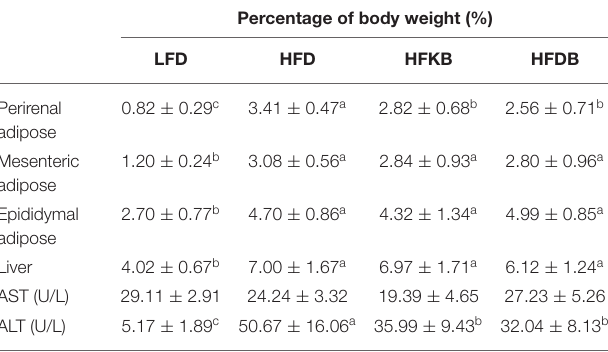
TABLE 2 | Liver and visceral fat mass and concentrations of serum AST and